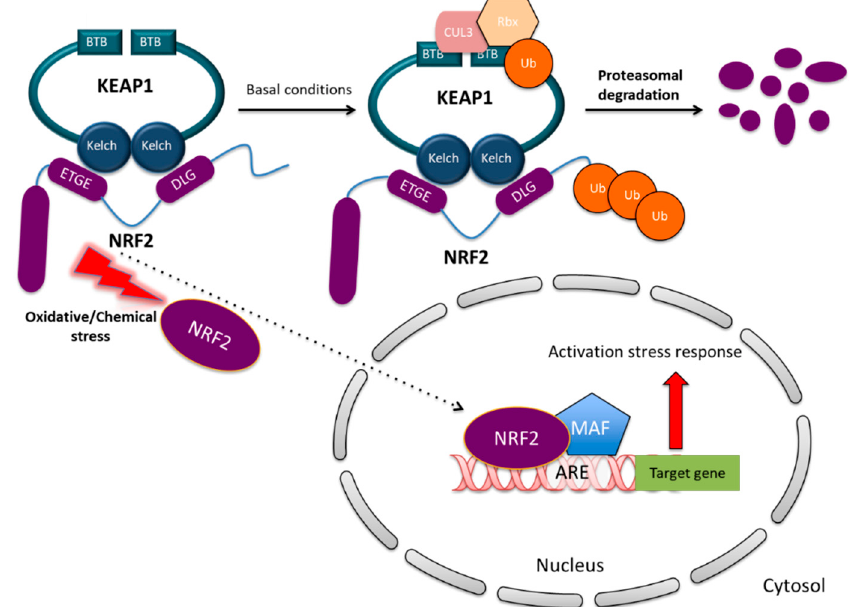
Figure 2. NRF2 regulation through KEAP1 under basal and stress conditions. Under basal conditions, NRF2 localizes in the cytosol and interacts with the Cul3-Rbx1 E3 ubiquitin-ligase substrate KEAP1 that constantly primes NRF2 for ubiquitination and proteasomal degradation. Oxidative/electrophilic stress causes conformational changes of KEAP1 through the modification of cysteine residues in IVR and BTB domains leading to NRF2 dissociation. Free NRF2 enters into the nucleus where it forms dimers with small MAF proteins or other interactors and binds to the antioxidant responsive elements (AREs) regulatory sequences of target genes, inducing their expression.